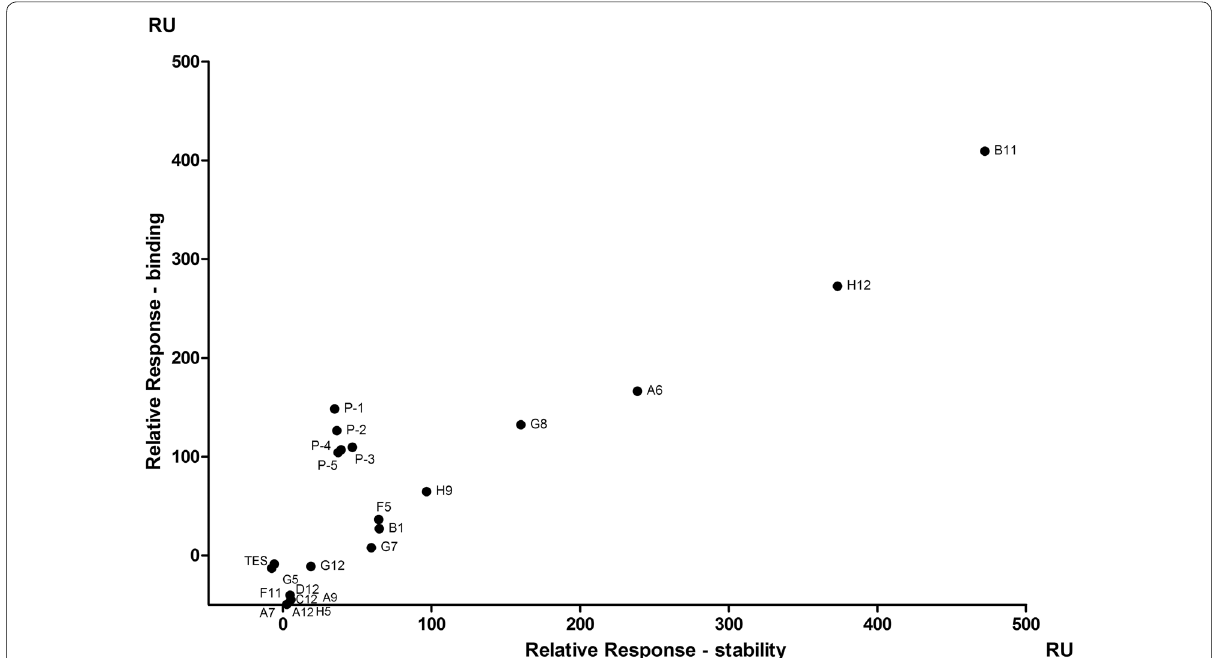
Fig. 2 The scatter plot of the lysate kinetics screening. The scatter plot represents the results of the lysate kinetics screening. The horizontal axis represents the relative response unit of the stability. The vertical axis represents the relative response unit of the binding. Each dot represents one sample with the tag name (e.g. B11, H12, P-1 and so on). ‘TES’ represents the 55% TES buffer (0.2 M Tris–HCl pH 8.0, 0.5 mM EDTA, 0.5 M sucrose), which was system buffer and taken as the blank